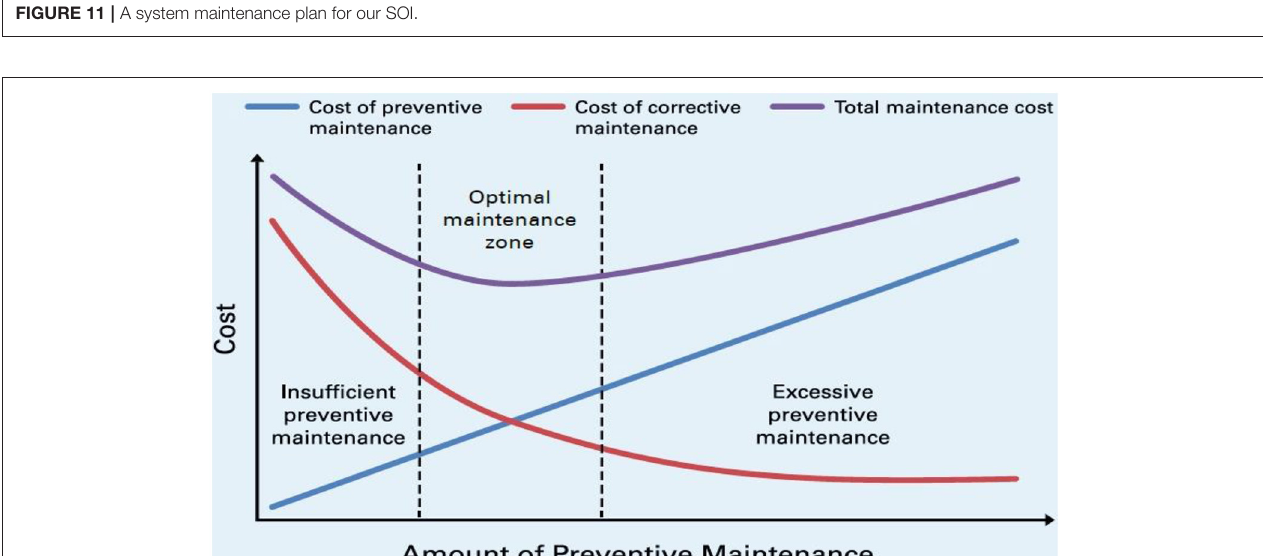
FIGURE 12 | Total maintenance cost and optimal maintenance zone (Bachir et al., 2017).